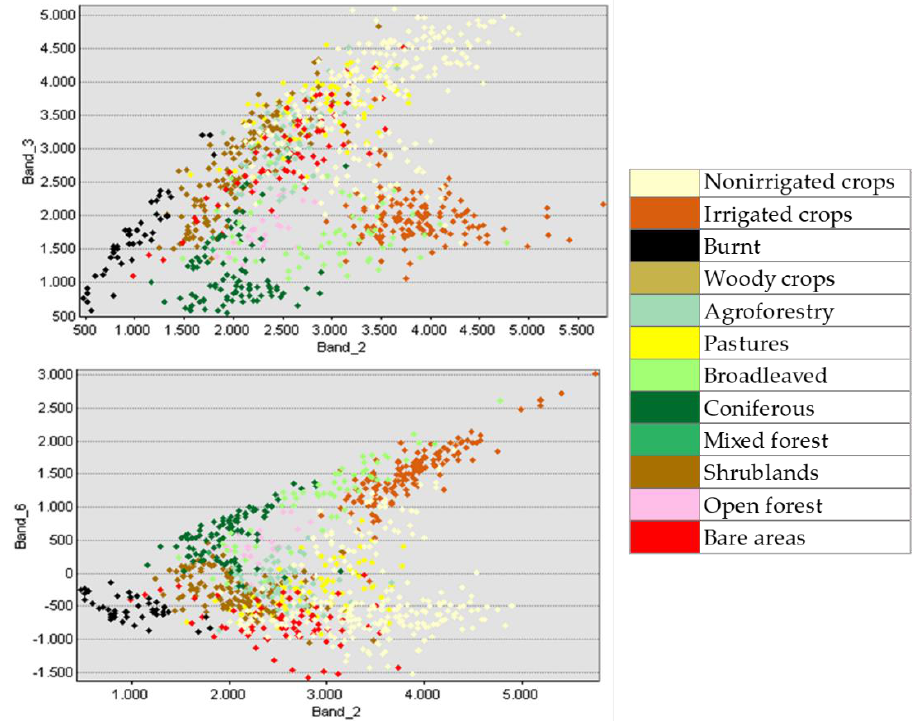
Figure A2. Spectral dispersion diagram for the LULC types of the band 2 (near infrared) with band 3 (SWIR-1) and band 6 (greenness).